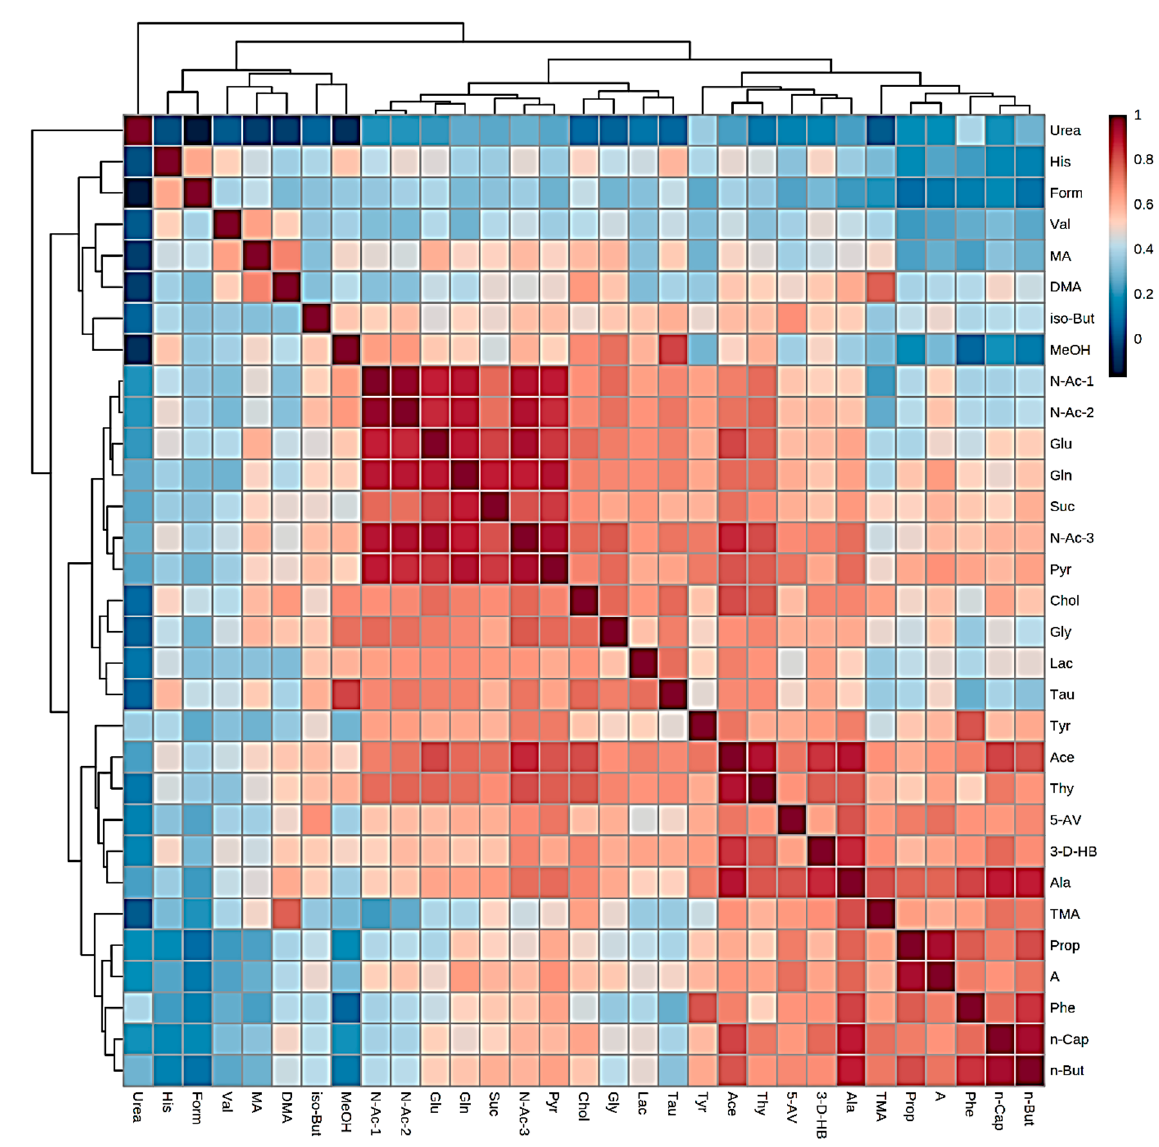
Figure 10. Two-dimensional correlation heatmap of the 31 1 H NMR-assigned metabolites employed for factor analysis of orthogonal salivary metabolite pools in a cohort of 48 healthy control participants (five daily saliva samples were collected from each subject). The top and left-hand side ordinate axes show the application of a correlation-based agglomerative hierarchical clustering analysis of the full dataset. Abbreviations: His, Histidine; Form, Formate; Val, Valine; MA, DMA and TMA, Methyl-, Dimethyl- and Trimethylamine respectively; iso-But, iso -Butyrate; MeOH, methanol; N-Ac-1, -2 and -3, N-Acetyl storage compound resonances located at δ = 2.025/2.030, 2.040 and 2.053/2.058 ppm respectively (Table 1); Glu, Glutamate; Gln, Glutamine; Suc, Succinate; Pyr, Pyruvate; Chol, Choline; Gly, glycine; Lac, Lactate; Tau, Taurine; Phe, Phenylalanine; Tyr, Tyrosine; Ace, Acetoin; Thy, Thymine; 5-AV, 5-Aminovalerate; 3-D-HB, 3-D-Hydroxybutyrate; Ala, Alanine; Prop, Propionate; A, Acetate; n-Cap, n -Caproate; n -But, n -Butyrate.